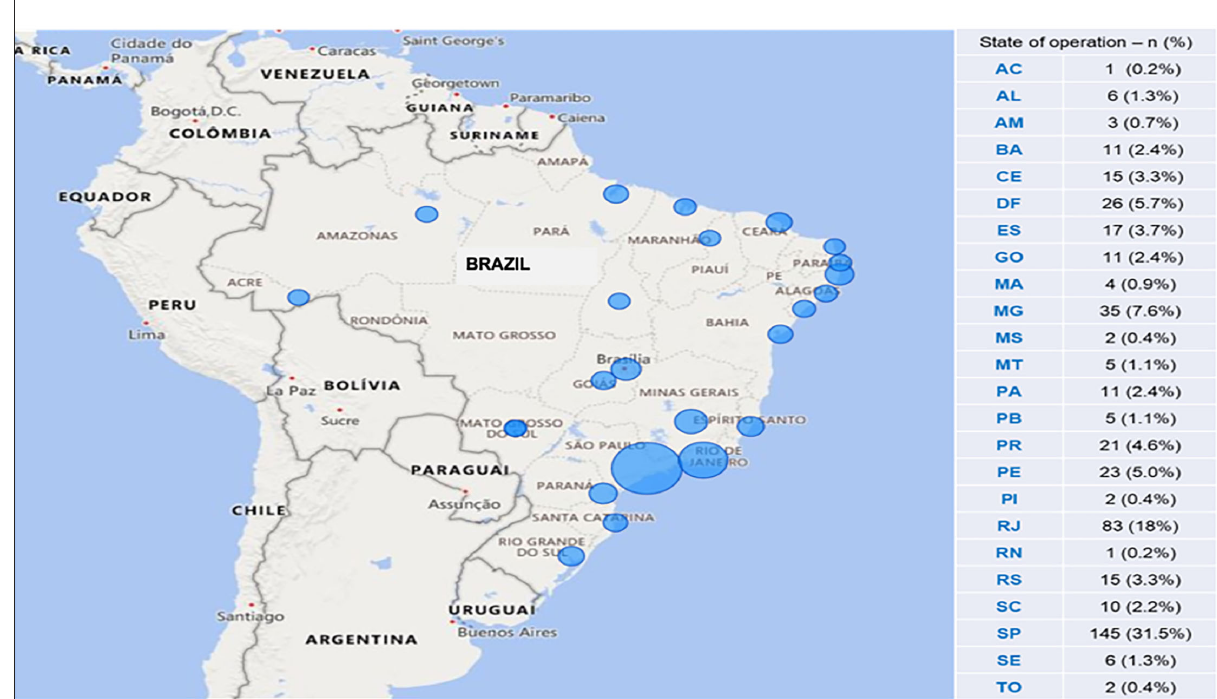
FIGURE1 Distribution of participants, according to the state of residence. AC, Acre; AL, Alagoas; AM, Amazonas; BA, Bahia; CE, Ceará; DF, Distrito Federal; ES, Espírito Santo; GO, Goiás; MA, Maranhão; MG, Minas Gerais; MS, Mato Grosso do Sul; MT, Mato Grosso; PA, Pará; PB, Paraíba; PR, ‘Paraná; PE, Pernambuco; PI, Piauí; RJ, Rio de Janeiro; RN, Rio Grande do Norte; RS, Rio Grande do Sul; SC, Santa Catarina; SP, São Paulo; SE, Sergipe; TO,